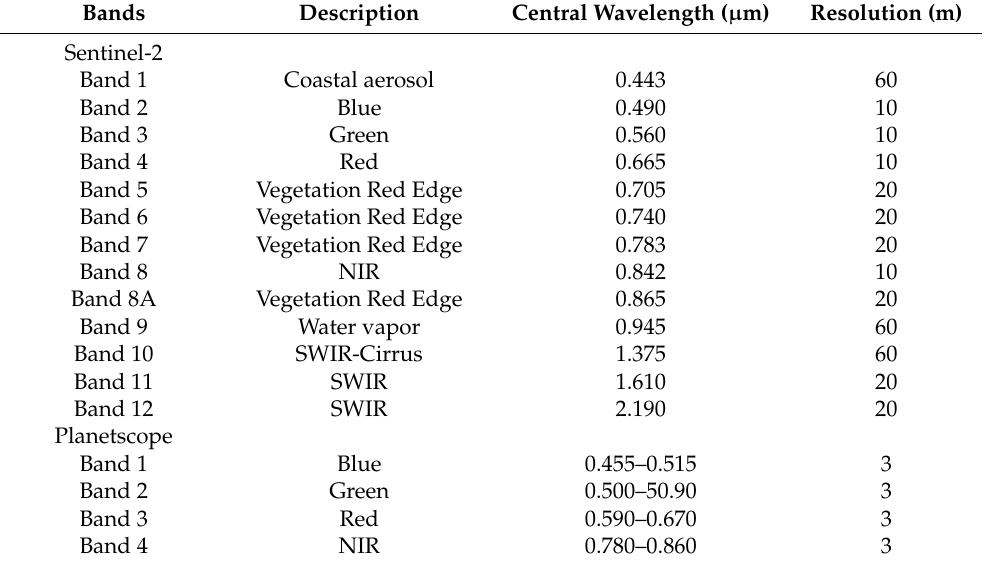
Table 1. Satellite sensor specifications.